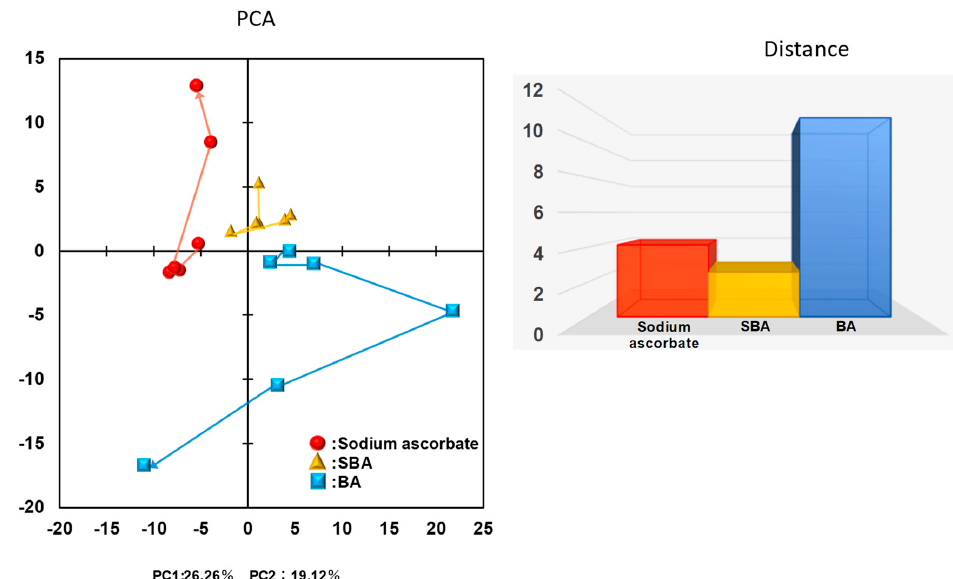
Figure 8. Principal component analysis (PCA) analysis of closeness between SBA related compounds.